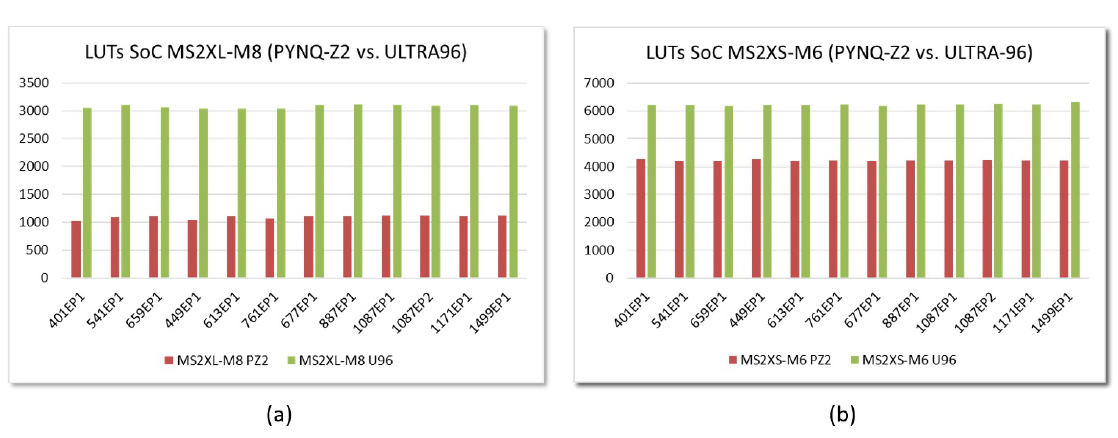
Figure 16. LUTs required to implement embedded systems that incorporate MS2XL-M8 ( a ) and MS2XS ( b ) multipliers on Zynq-7000 and Zynq UltraScale+ devices for the different IEEE Std 1363.1 pa- rameter